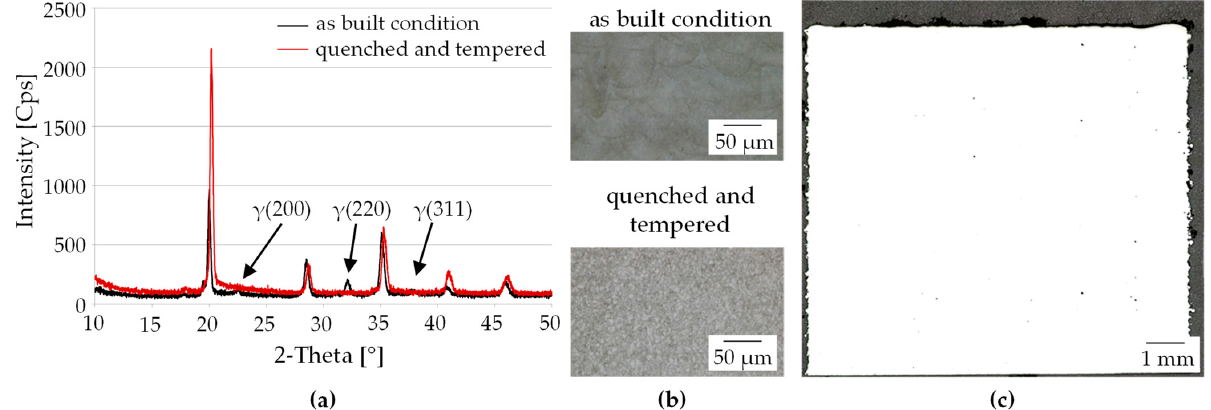
Figure 6. Investigation of L-PBF-fabricated hot-work tool steel AISI H10: ( a ) X-ray diffraction pattern as-built (black) and quenched and tempered (red); ( b ) microstructure in the as-built condition (up) as well as quenched and tempered state (down); ( c ) defect analysis of a cubic specimen.